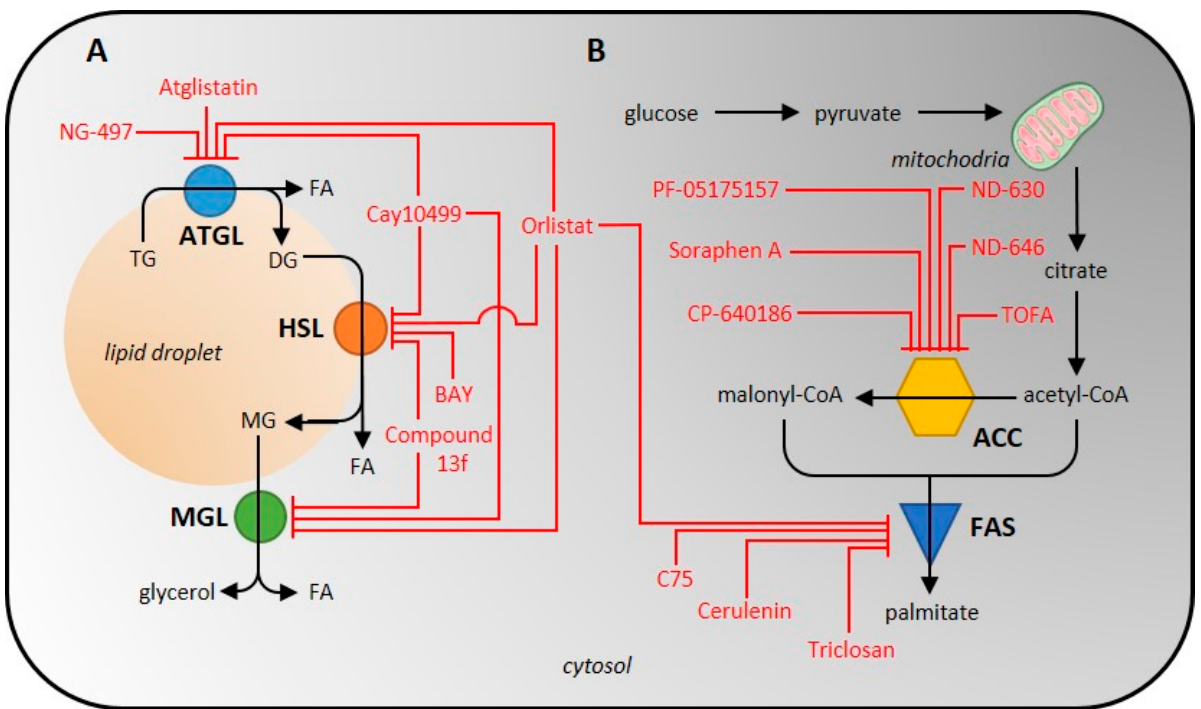
Figure 2. It is also possible to focus on and analyze one of the esterase activities that none of the other lipases exhibit.